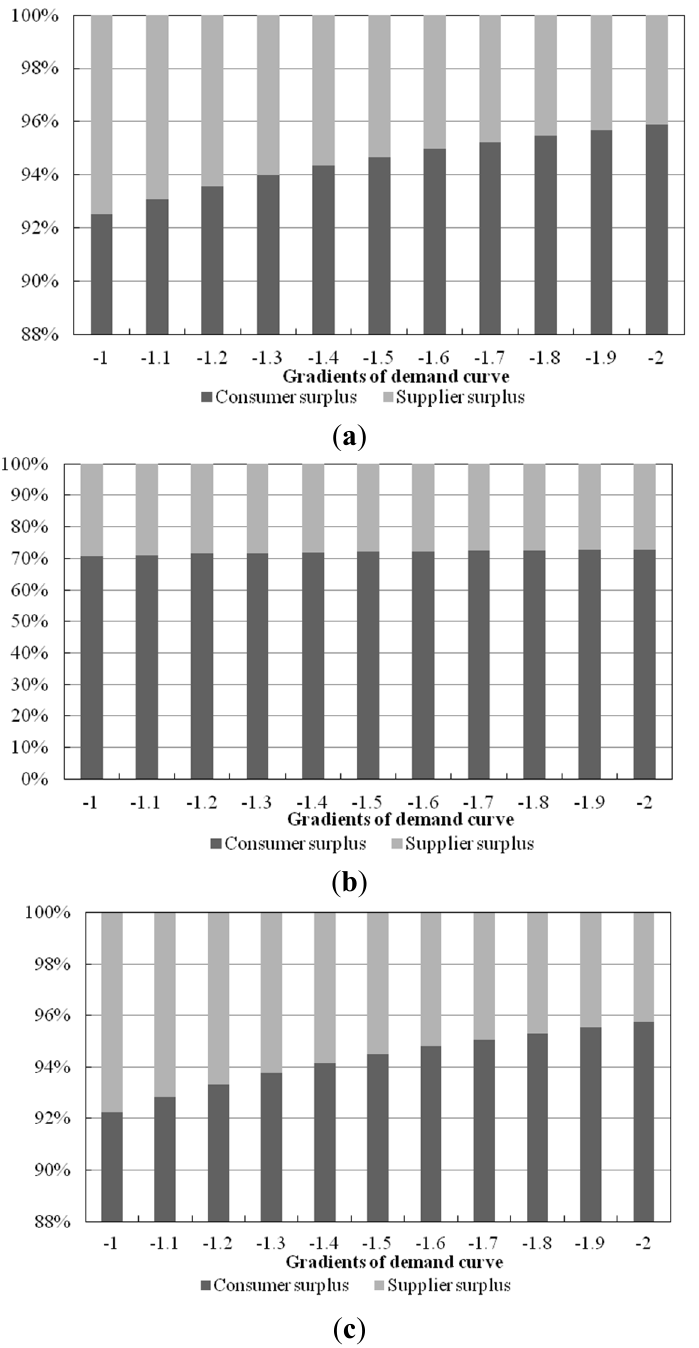
Figure 10. The ratio of consumer and supplier surpluses with each scenario. ( a ) The method described here; ( b ) Oligopoly conditions, and ( c ) Perfect